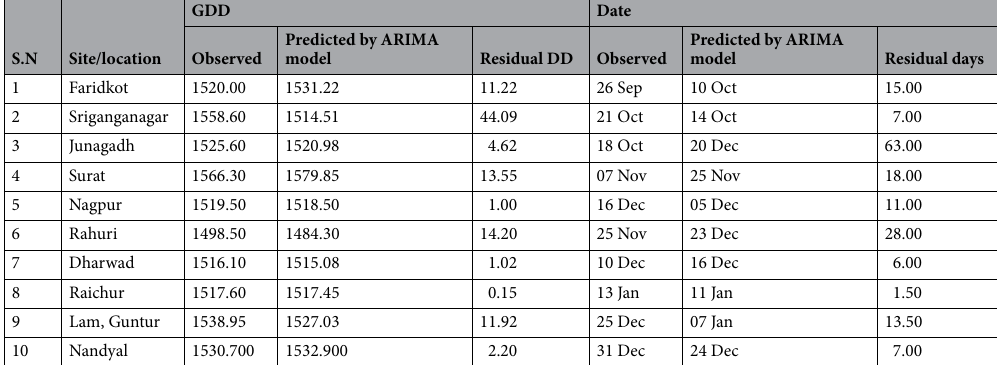
Table 4. Predicted GDD or dates of peak moth catches of pink bollworm by ARIMA model.